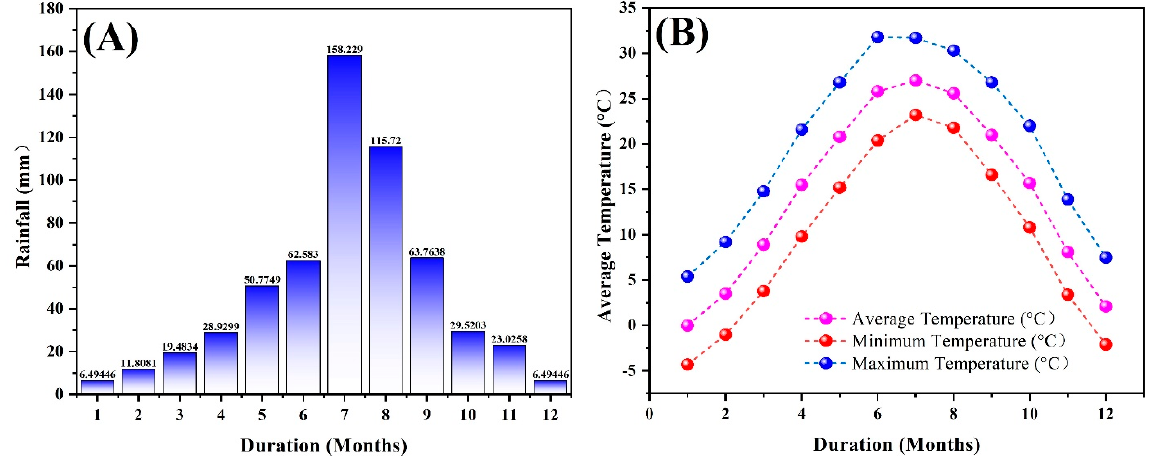
Figure 1. Annual rainfall (mm) ( A ) and annual temperature (°C) during long-term experimental period ( B ). period ( B